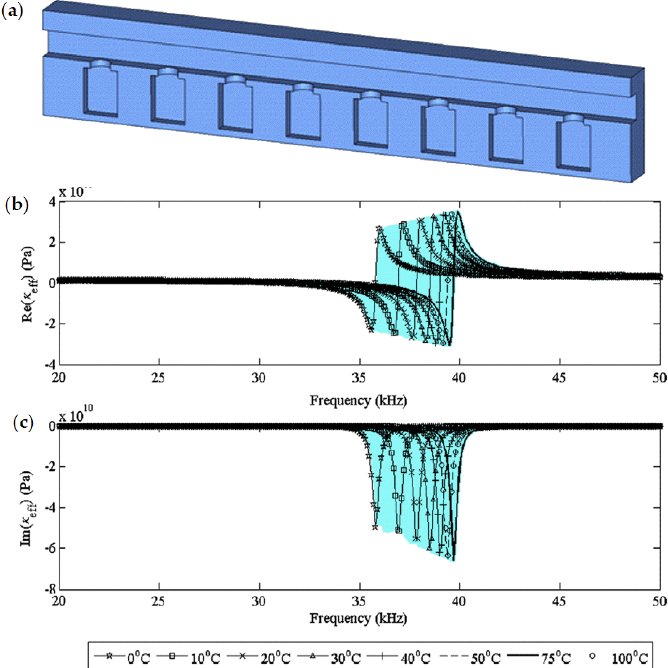
13 of 21 Figure 11. ( a ) Schematic view of a unit cell; ( b ) Varied range of whispering-gallery modes’ (WGMs) frequency crossing from Bragg band gap to low-frequency band gap when the holes are respectively empty or fully filled with the liquid: water (blue dotted lines) and mercury (red dotted lines), corresponding to increasing inner radius. Reproduced under a Creative Commons Attribution 4.0 International License [150] Copyright 2016, MDPI. 5.3. Temperature-Controlled Acoustic Metamaterials The intensive research on the influence of the fluid temperature on the features of sonic resonators is significant to achieve multiple functions such as phase modulation and acoustic wave transmission control. It is well known that the properties of a fluid are largely dependent upon its temperature. On the other hand, attaching side Helmholtz resonators to duct walls is a feasible way to attenuate the acoustic energy in narrow ranges around the resonant frequencies [84]. Then, a one- dimensional composite metamaterial is proposed by Xia et al. [152], in which a rigid wall acoustic